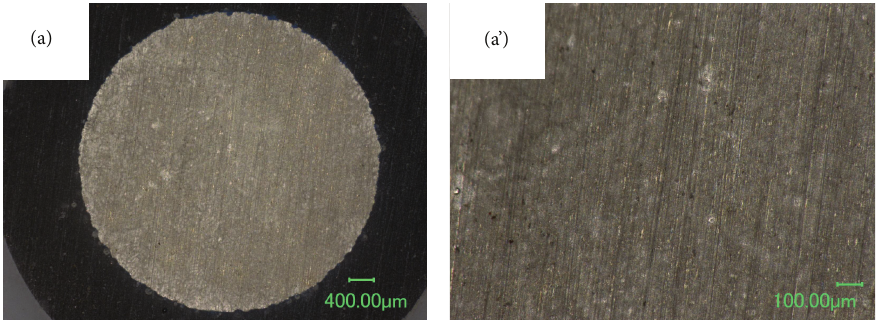
Figure 5: The surface morphologies of AZ91D after static state corrosion test for 4